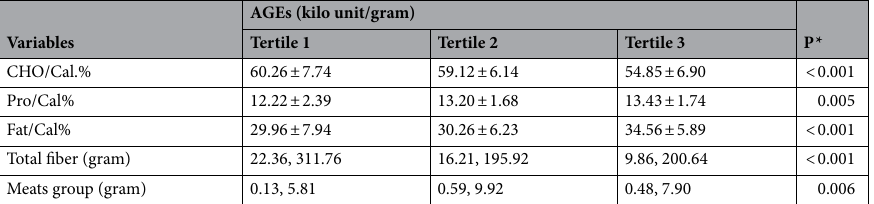
Variables CHO/Cal.%